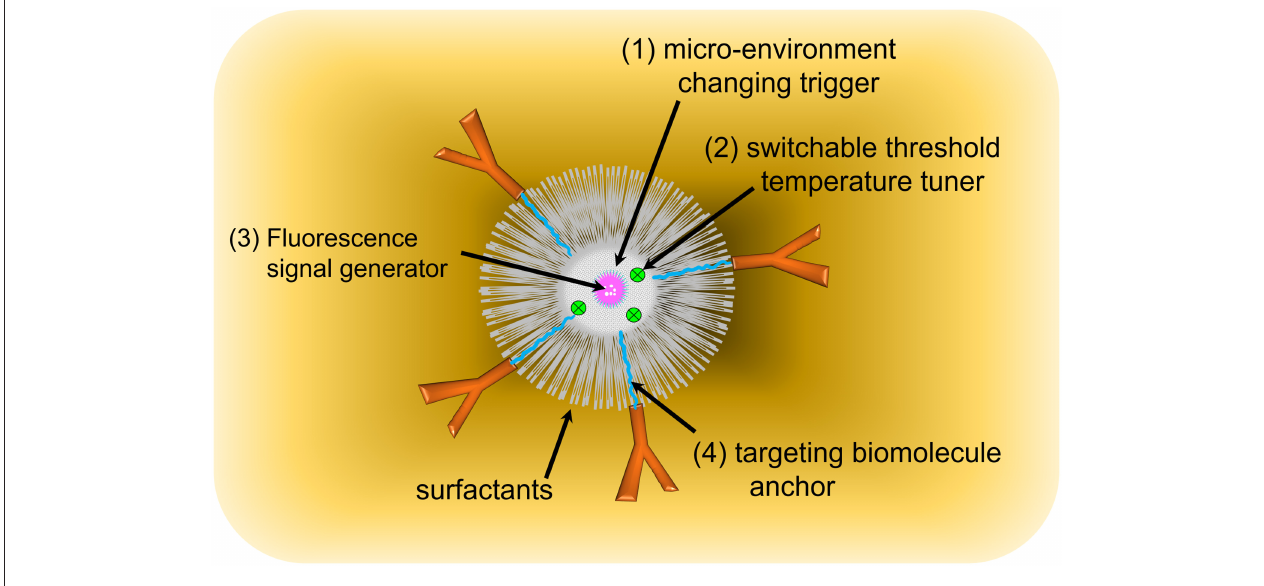
FIGURE 4 | USF contrast agent’s